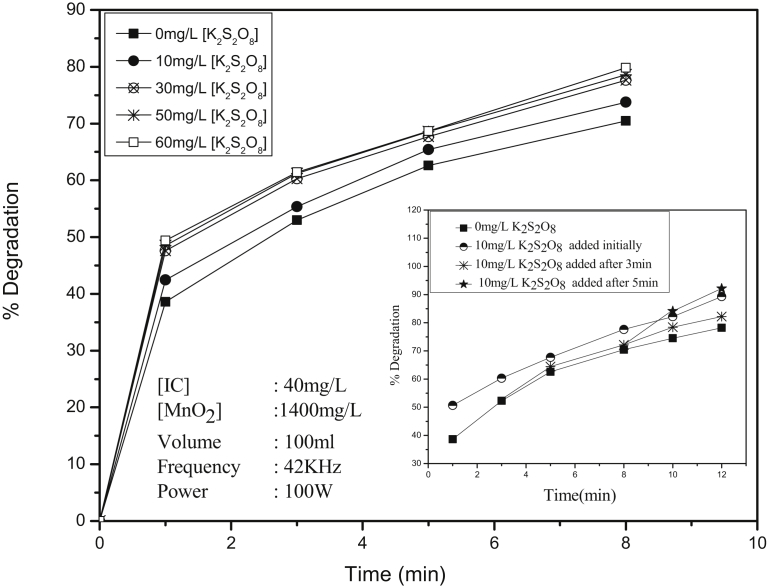
Effect of K2S2O8 on the Sonocatalytic degradation of IC over MnO2. [Inset]: Effect of initial and in between addition of K2S2O8 on the degradation of IC.